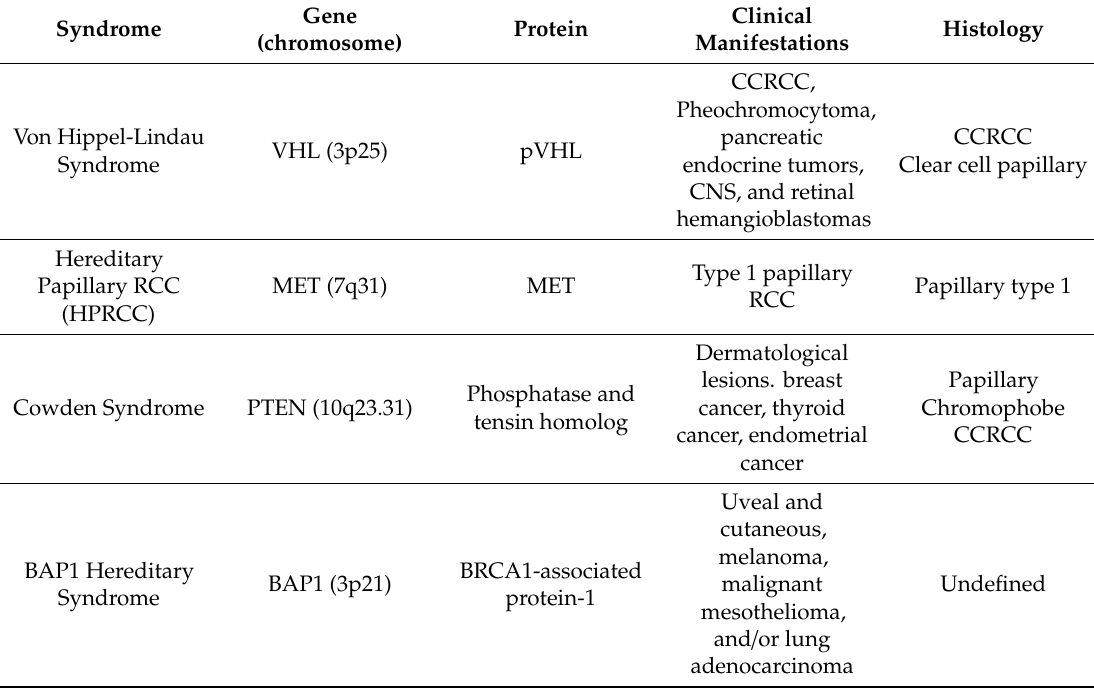
Table 1. Hereditary RCC syndromes, associated molecular alterations, and clinical